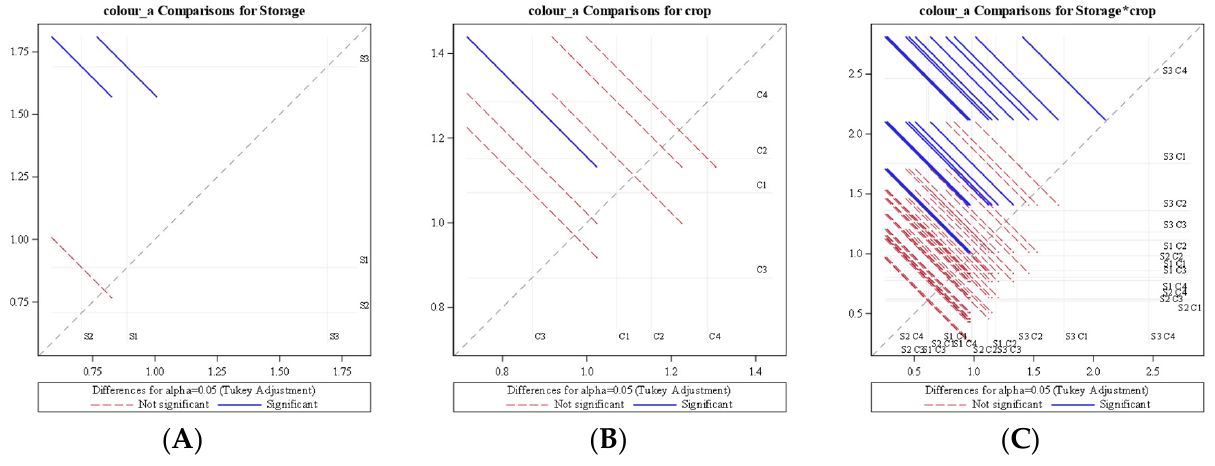
Figure 10. Diffogram showing the effect of storage condition and crop on average daily change of colour value a. ( A ) Colour ‘a’ comparison for storage ( B ) Colour ‘a’ comparison for crop ( C ) Colour ‘a’ comparison for storage*crop S1—LCTR; S2—VCR; S3—ambient storage; C1—bitter gourd;